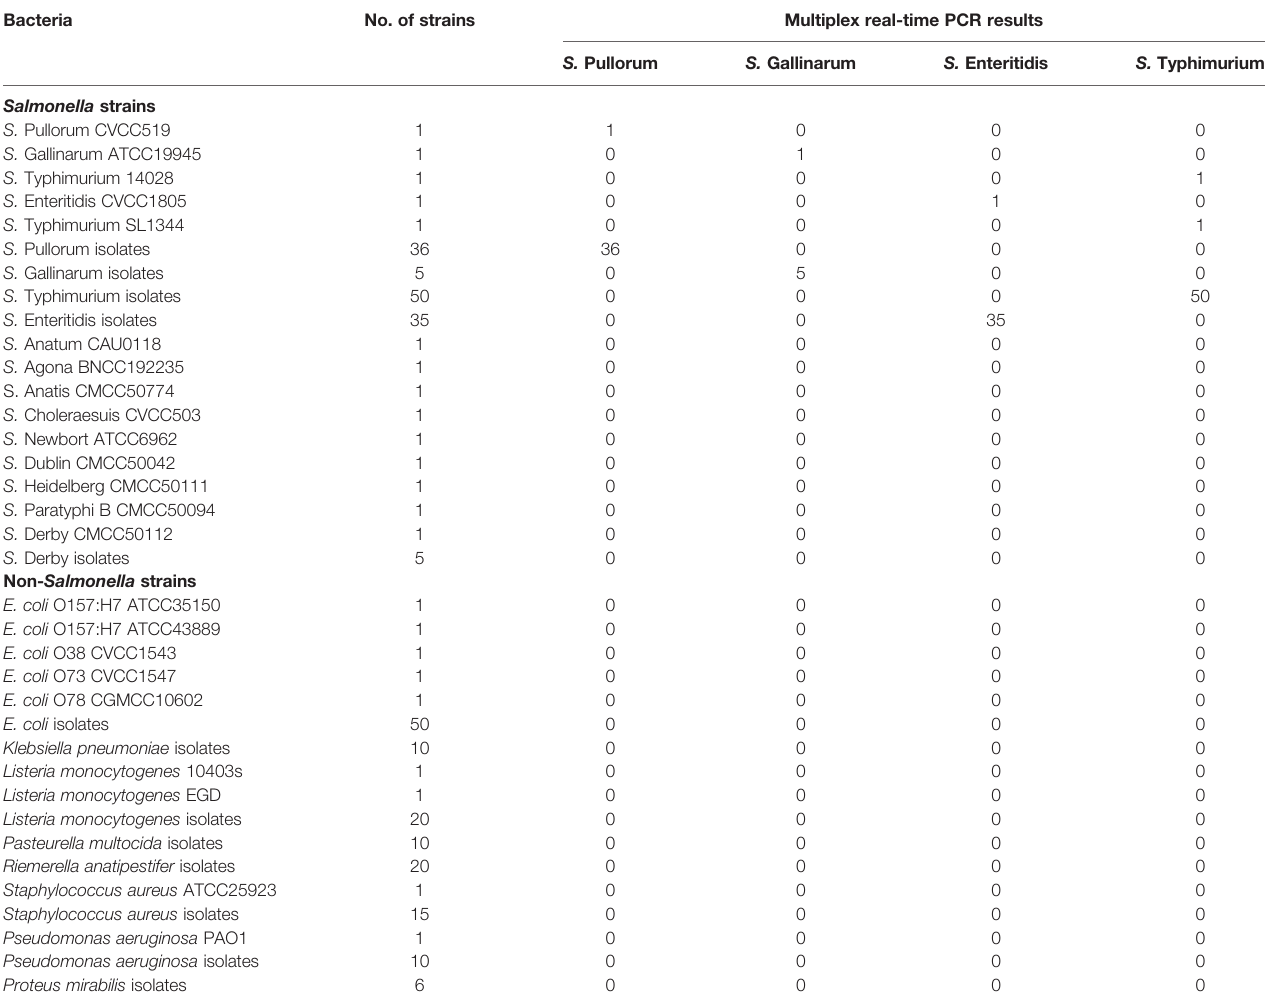
TABLE 1 | Speci fi city of the multiplex real-time PCR for different bacterial strains. Bacteria No. of strains Multiplex real-time PCR